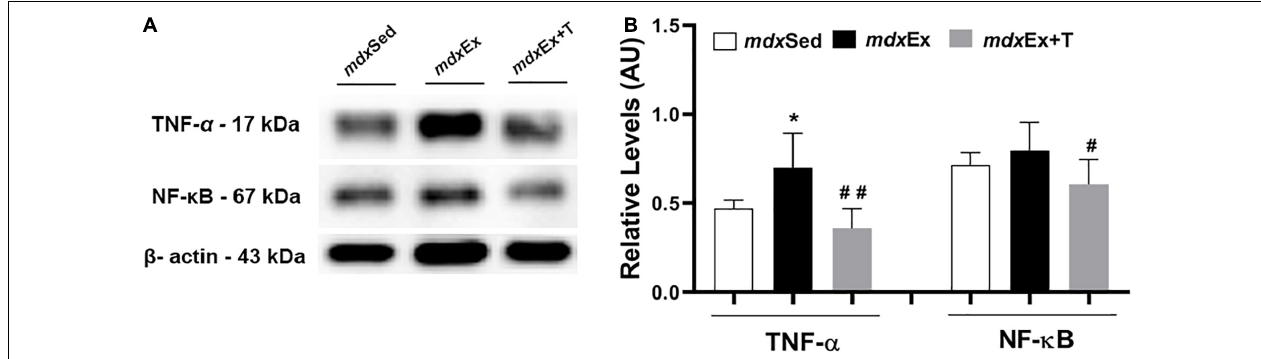
FIGURE 4 | Tempol effects on the inflammatory markers. (A) Western blotting analysis of tumor necrosis factor alpha (TNF- α ) and nuclear factor kappa B (NF- κ B). The blots of the proteins (top row) and β -actin (loading control, bottom row) are shown. (B) The graphs show the protein levels in the crude extracts of diaphragm (DIA) from the sedentary mdx mice (mdx Sed), exercise trained mdx mice ( mdx Ex), and exercise trained mdx mice treated with Tempol ( mdx Ex+T). The intensities of each band were quantified and normalized to those of the corresponding control. Relative values are expressed as mean ± standard deviation (SD). * P ≤ 0.05 compared with the mdx Sed group, # P ≤ 0.05 compared with the mdx Ex group, ## P ≤ 0.001 compared with the mdx Ex group (one-way ANOVA with Tukey’s post hoc